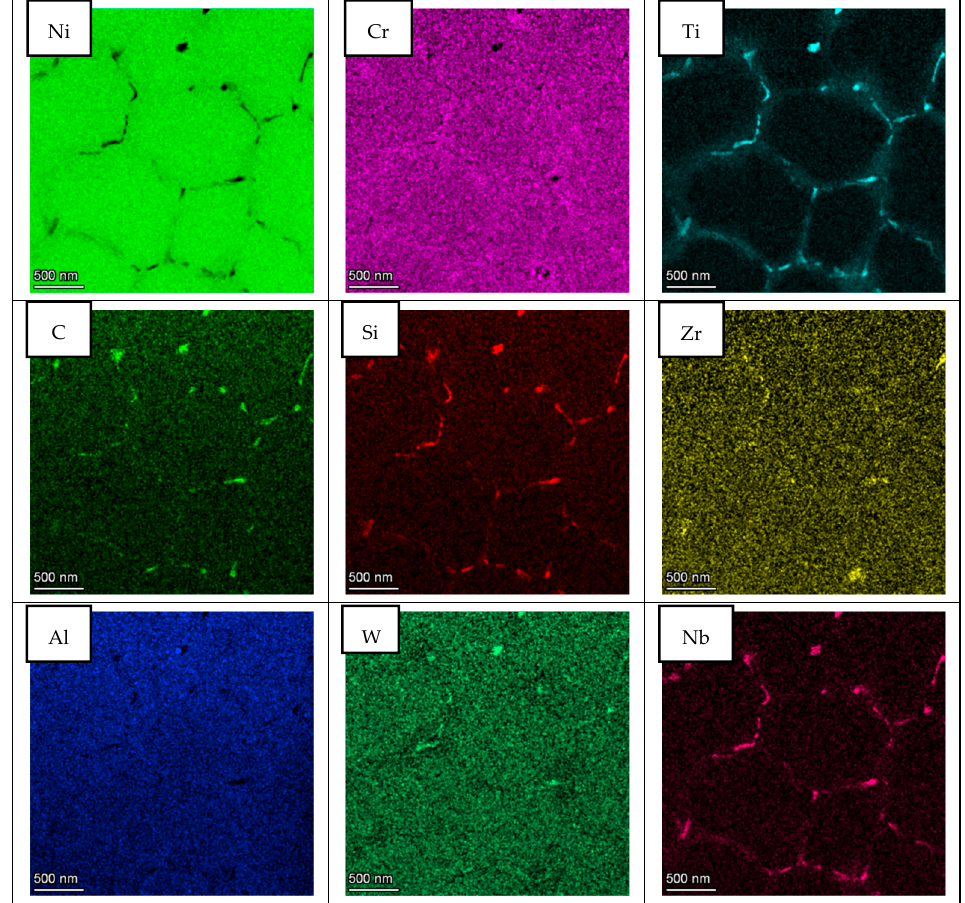
Figure 10. STEM EDS compositional maps of the A&D sample grain and cell boundaries. With the aim of performing a more localized composition analysis, TEM EDS line- scans were performed in LPW sample cell boundary and in A&D sample grain boundary. In fact, the selected zones are presented in Figure 11, where the arrows indicate the location of the line-scan measurements.